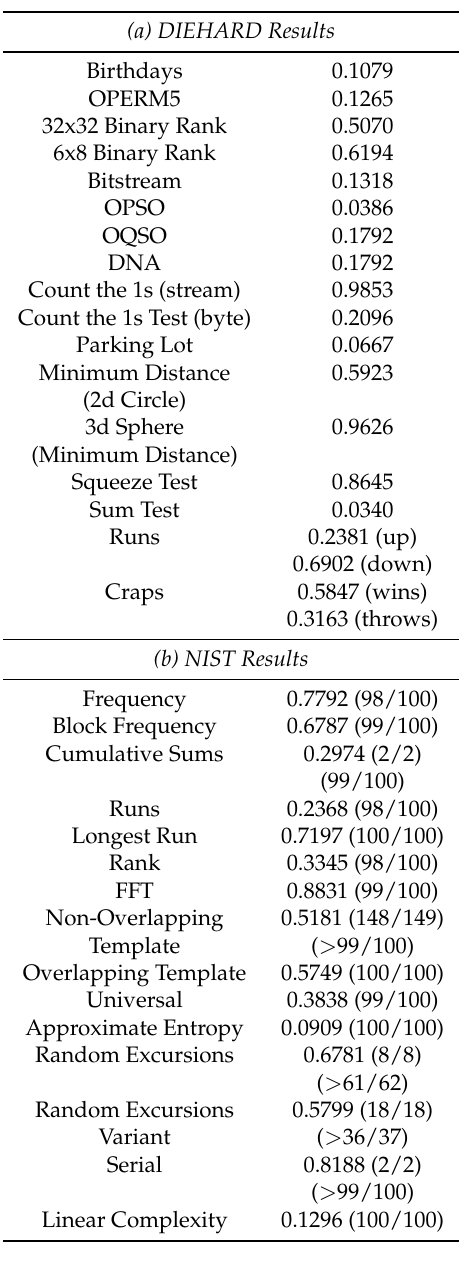
Table 4. DIEHARD and NIST